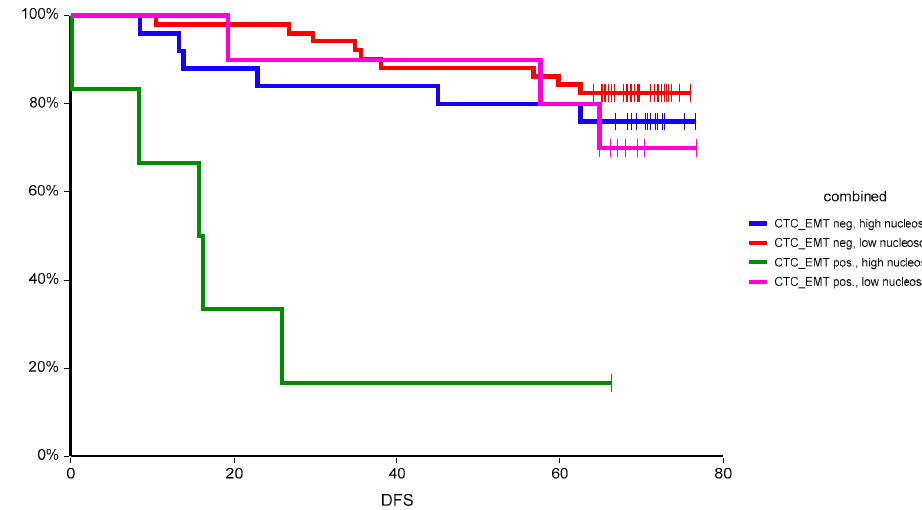
Figure 2. Kaplan–Meier estimates of probabilities of disease-free survival according to plasma nucleosome status and CTC_EMT in primary breast cancer patients ( n = 92). Patients positive for CTC_EMT and high level of circulating nucleosomes had significantly worse survival compared to all other groups ( p = 0.0000003).